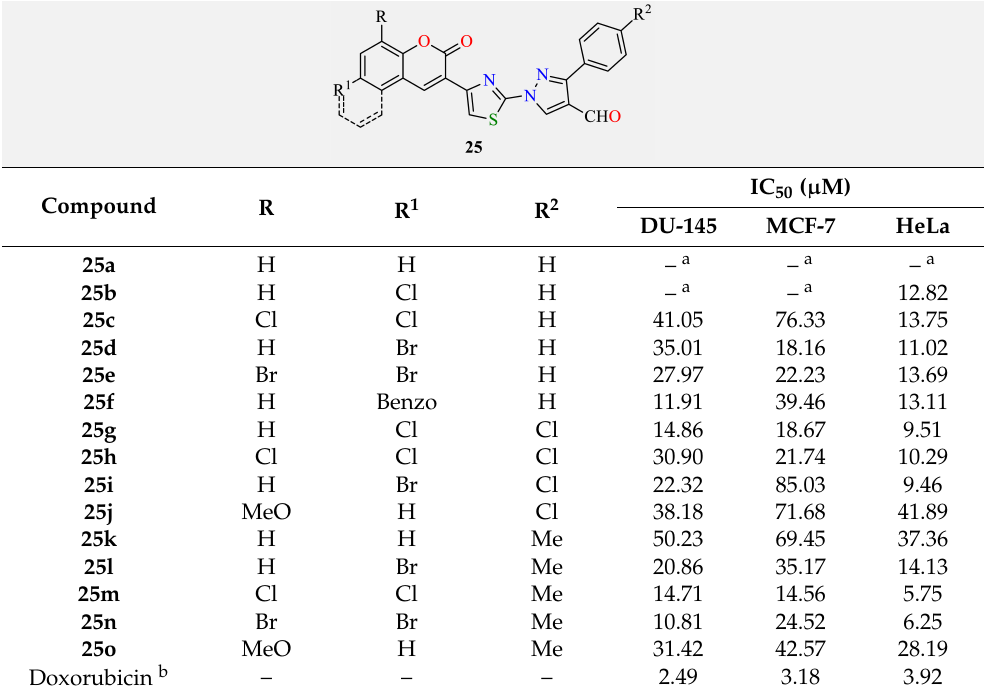
Table 27. Cytotoxic activity of coumarin-substituted thiazolyl-3-aryl-pyrazole-4-carbaldehydes 25 .